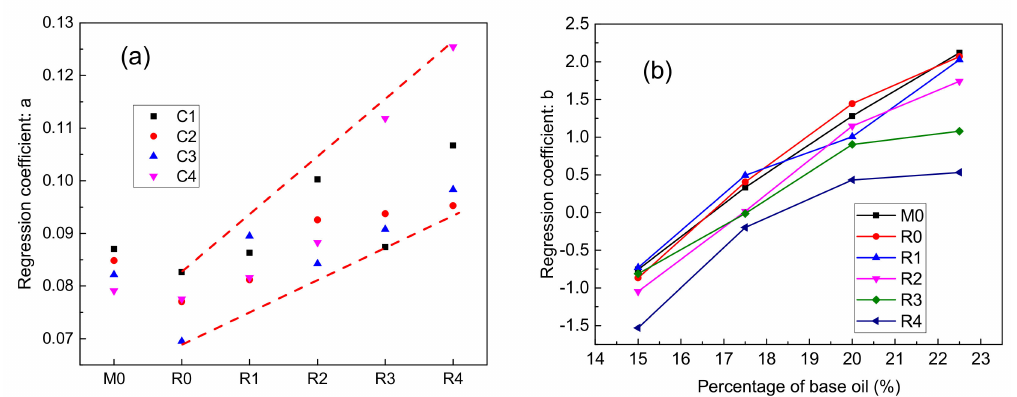
Figure 9. ( a ) Relationship between base oil and regression coe ffi cient: a ; ( b ) E ff ects of base oil content on regression coe ffi cient: b